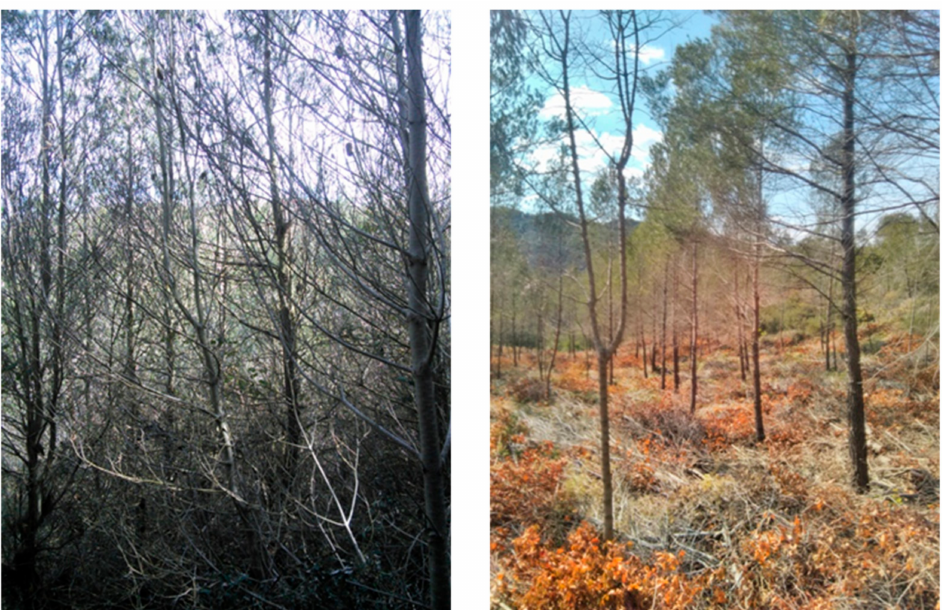
Figure 1. Untreated forest (T0) and forest shortly after the mechanical treatments were implemented